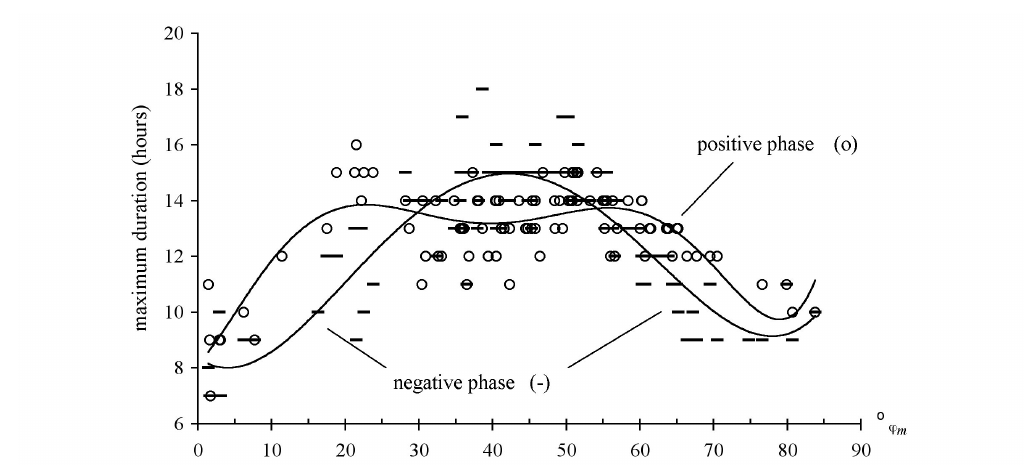
Fig. 2. Maximum duration of positive and negative disturbances with geomagnetic